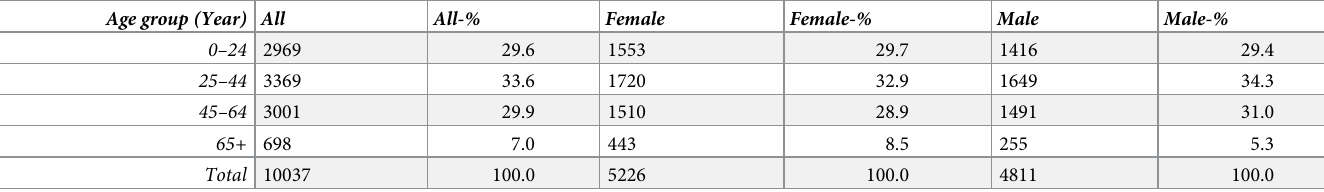
Table 1. Distribution of females and males in age groups in the study population (N = 10037). Age group (Year) All